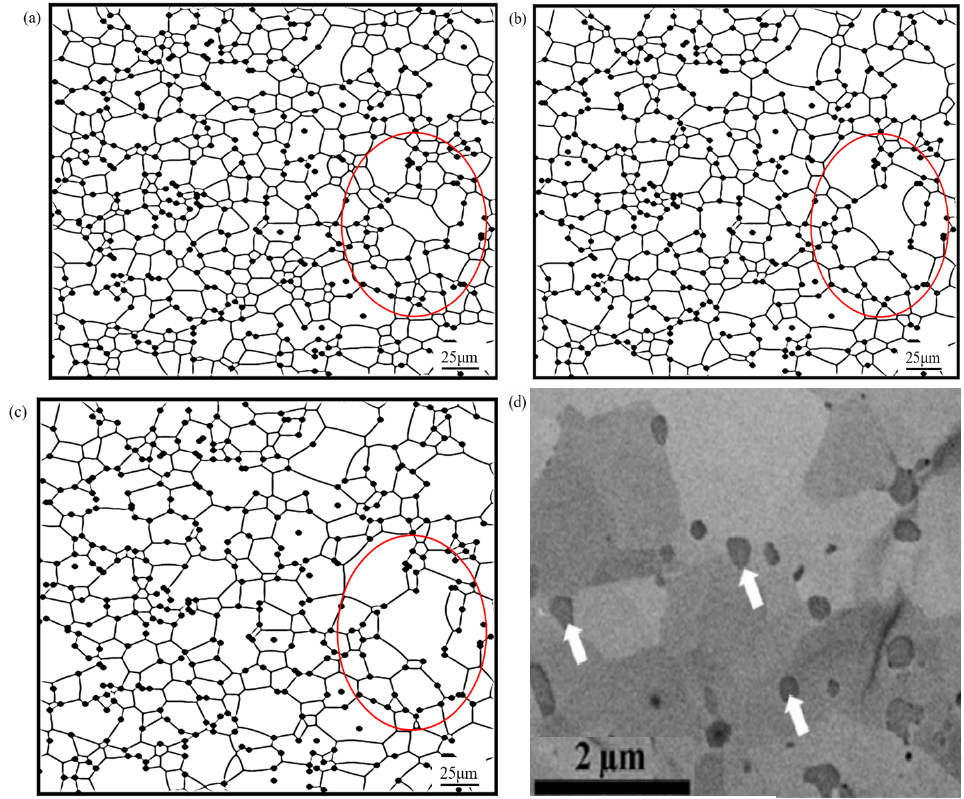
Figure 2. Microstructure evolution of AZ31 Mg alloy containing SPP with particle size r = 1 µ m and volume fraction f = 5%: ( a ) t = 30 min, ( b ) t = 60 min, and ( c ) t = 90 min. ( d ) Backscattered electron image of the cross-section of the as-received Cu-0.21 wt.% O powder; white arrows indicate some of the second-phase particles